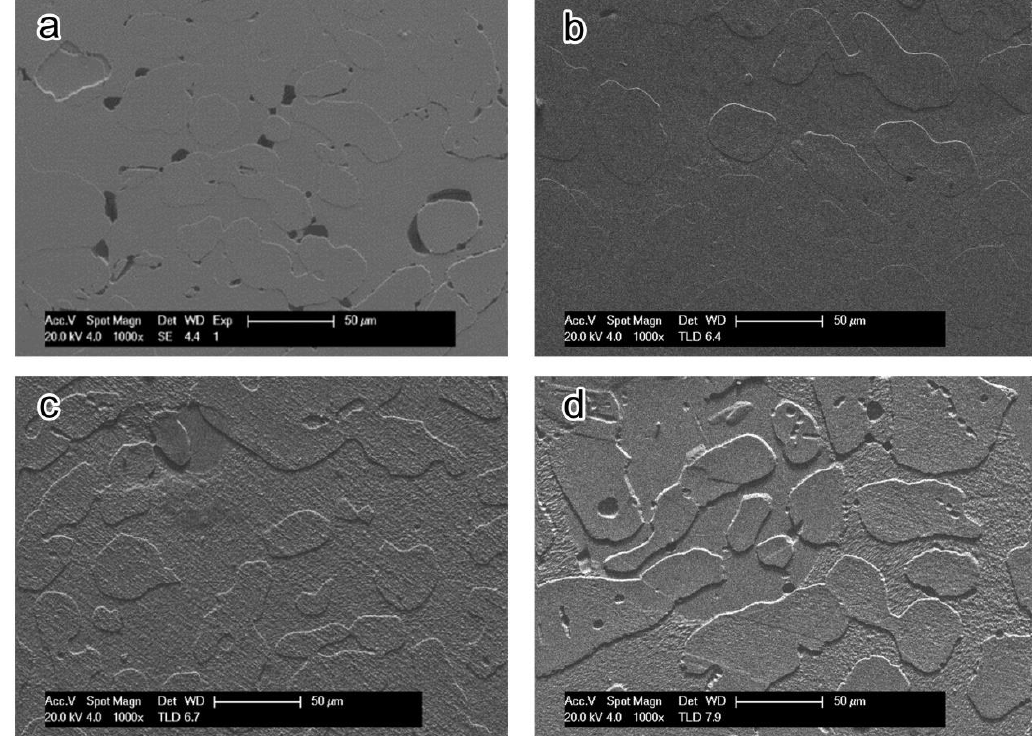
Figure 14. SEM photographs of corrosion morphology of S32750 stainless steel at different annealing times at 1050 °C after polarization tests: ( a ) 20, ( b ) 30, ( c ) 40, and ( d ) 60 min.